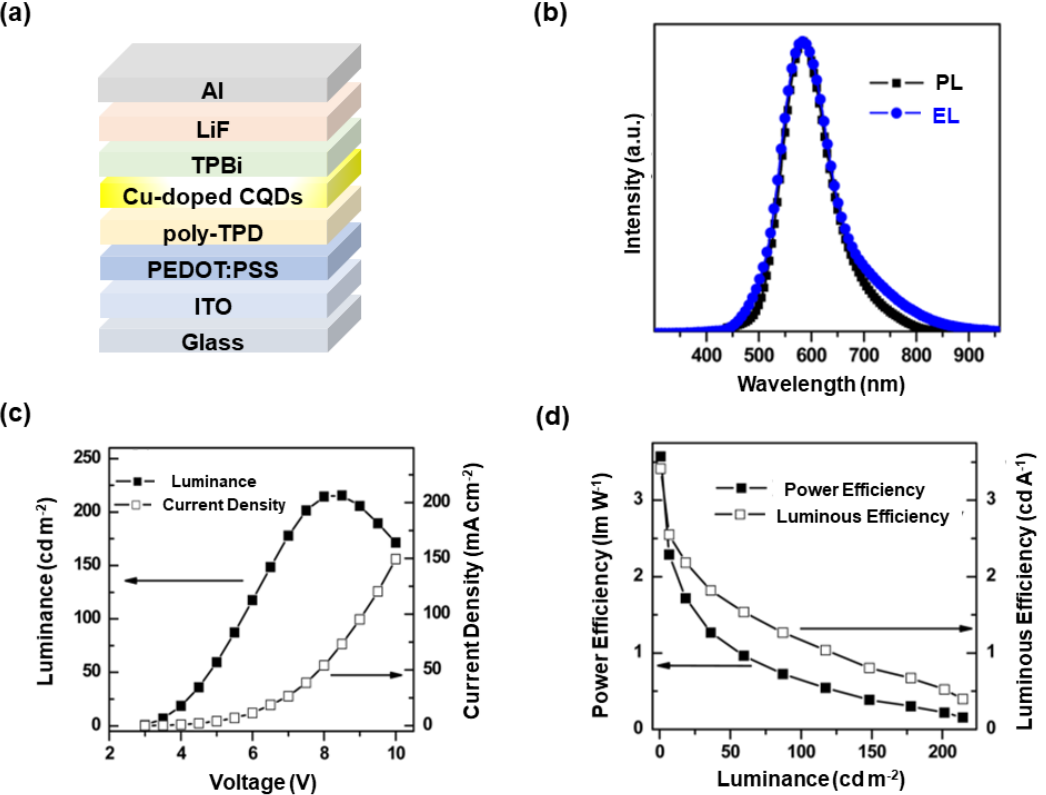
Figure 5. ( a ) Device architecture of LEDs. ( b ) PL spectra and corresponding EL of Cu-doped Zn-In-S / ZnS with yellow emissions. ( c ) Current density and luminance of LEDs. ( d ) CE and PE of LEDs. Reproduced from reference [245].